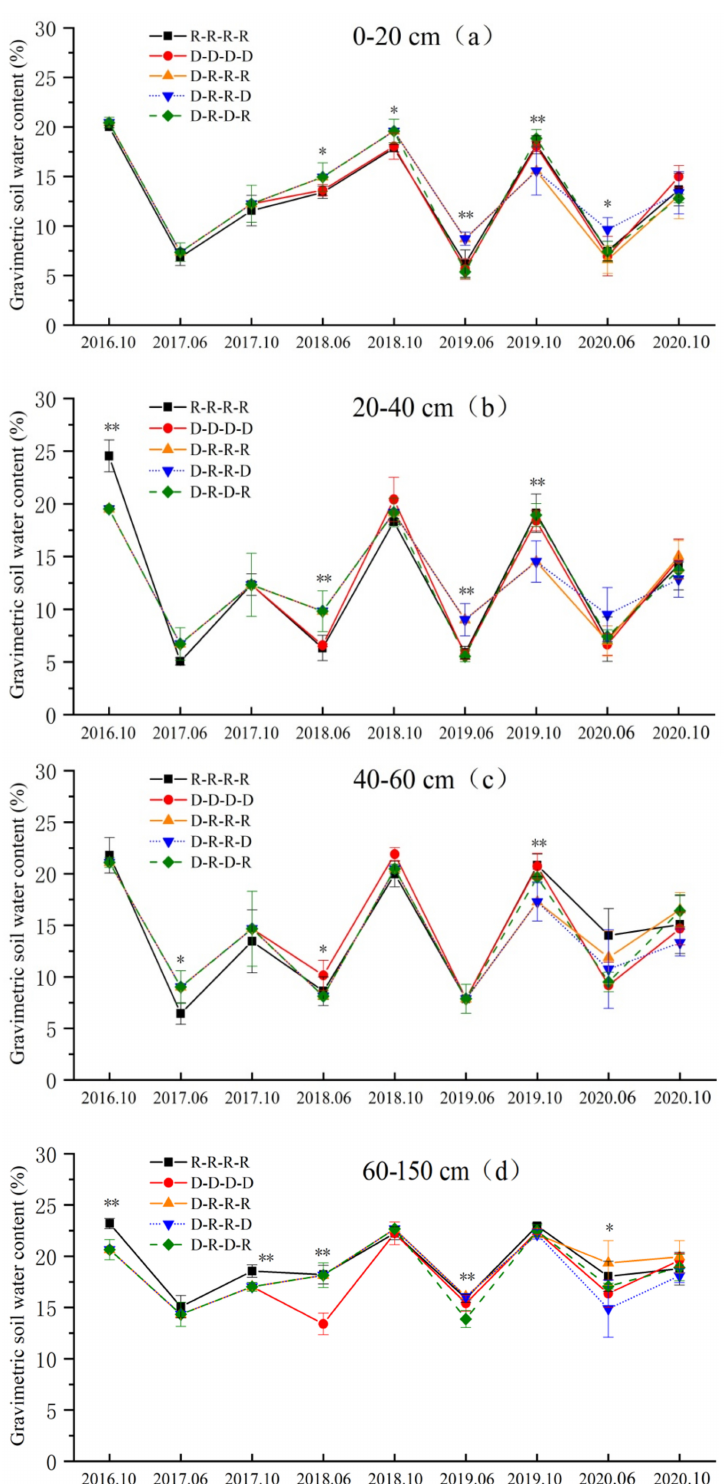
Figure 2. The average soil water contents at harvesting of winter wheat and summer maize for different treatments at depths of 0–20, ( a ), 20–40, ( b ), 40–60, ( c ) and 60–150 cm, ( d ) from 2016 to 2020 (R-R-R-R representing rotary tillage in 2016-2020, D-D-D-D representing deep tillage in four years, and D-R-R-R, D-R-R-D and D-R-D-R representing the different combinations of deep tillage (D) and rotary tillage (R) in four years; LSD test: * mean significant differences at 0.05 level, ** mean significant differences at 0.01 level; bars representing the standard deviation of four